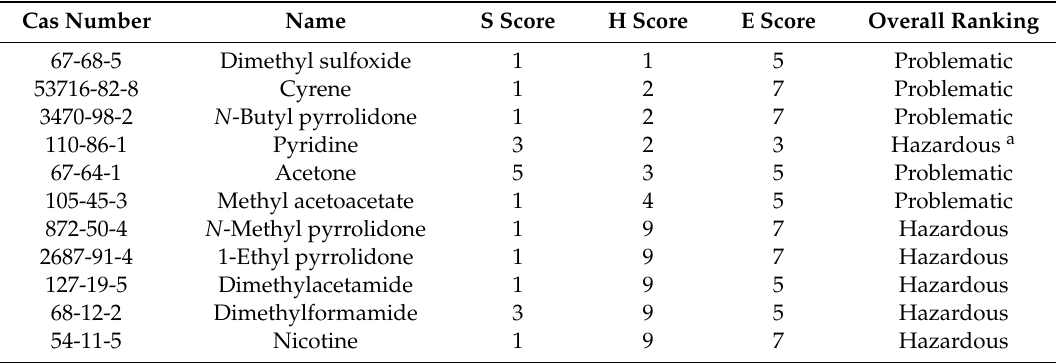
Table 1. Short list for NMP ( N -methyl